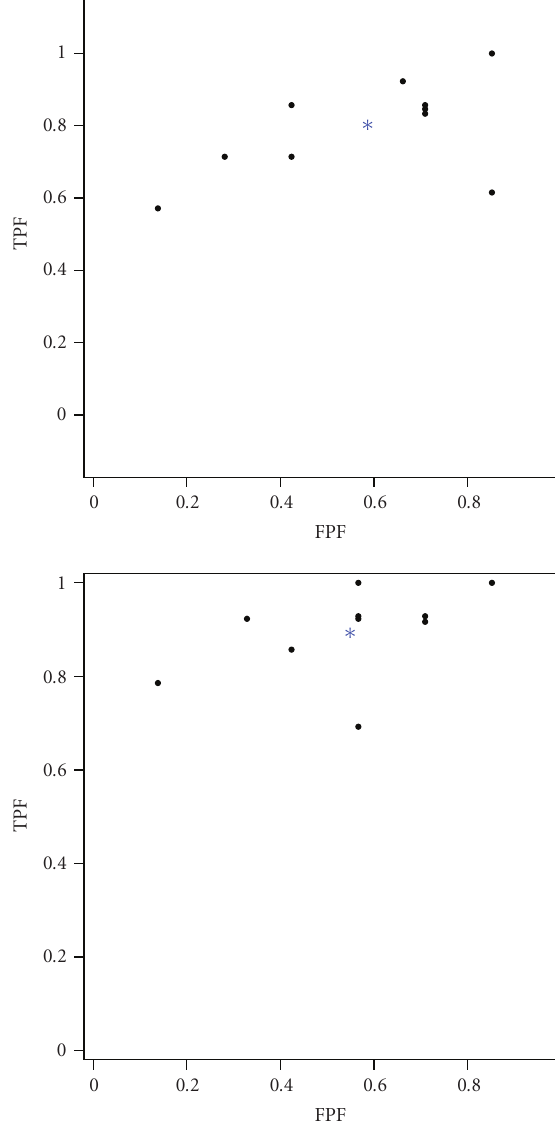
Figure 1: Performance assessment for method (ii). The pairs (TPF, FPF) estimated on the validation set are plotted in each graph. The assessment for the 59 gene signature ( α 1 ≤ . 001) is shown on the upper and that for the 14 gene signature ( α 1 ≤ . 0001) is shown on the